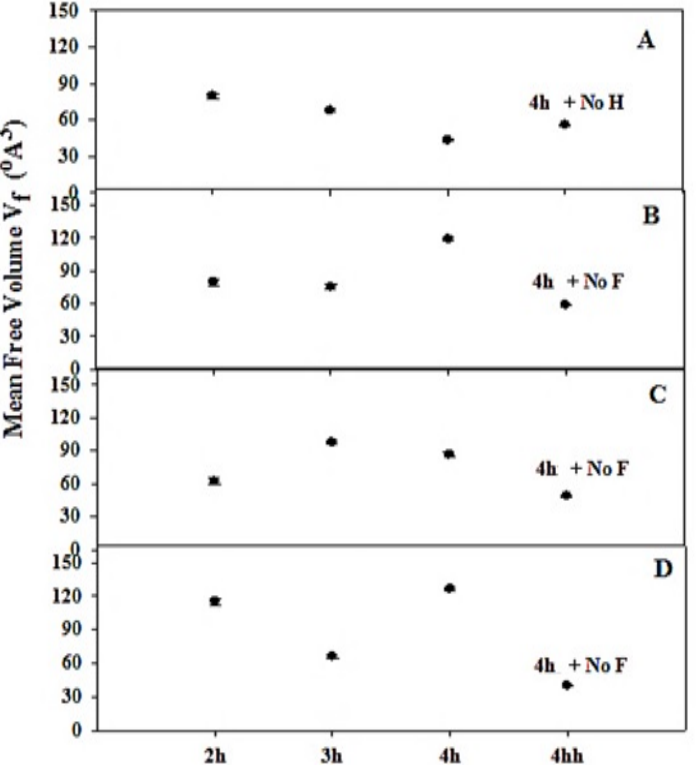
Figure 4. The variation of mean free volume, Vf (Å3), as a function of sonication time (2, 3 and 4 h) in special conditions; 7 g commercial silicon powder in different KOH concentrations (wt.%): ( A ) at 6 wt.% KOH, ( B ) 4.5 wt.% KOH, ( C ) 3 wt.% KOH and ( D ) 5 g commercial silicon powder and 3 wt.% KOH.